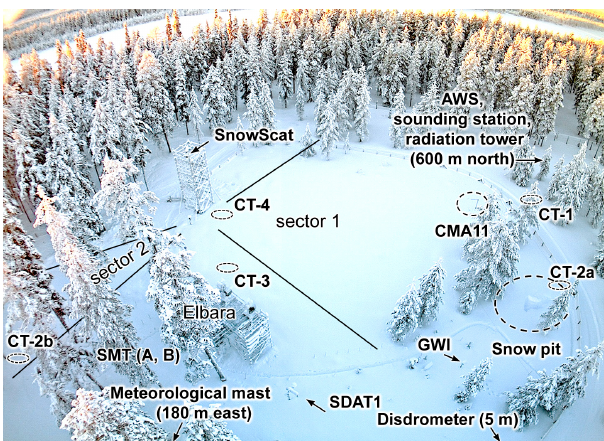
Figure 3. All field, all radar, and most meteorological data were ac- quired at the intensive observation area (IOA). The remaining me- teorological data were measured at the meteorological mast 180m east of the IOA and at the automatic weather station (AWS) 600m north of the IOA. Anisotropy validation profiles were extracted at the locations CT-1, CT-2a/b, CT-3, and CT-4. The depth-averaged anisotropy for “sector 1” was measured every 4h with a tower-based radar (SnowScat) which also measured the snow water equivalent in combination with the gamma water instrument, GWI, as detailed in Leinss et al. (2015). Sensor abbreviations are explained in Table